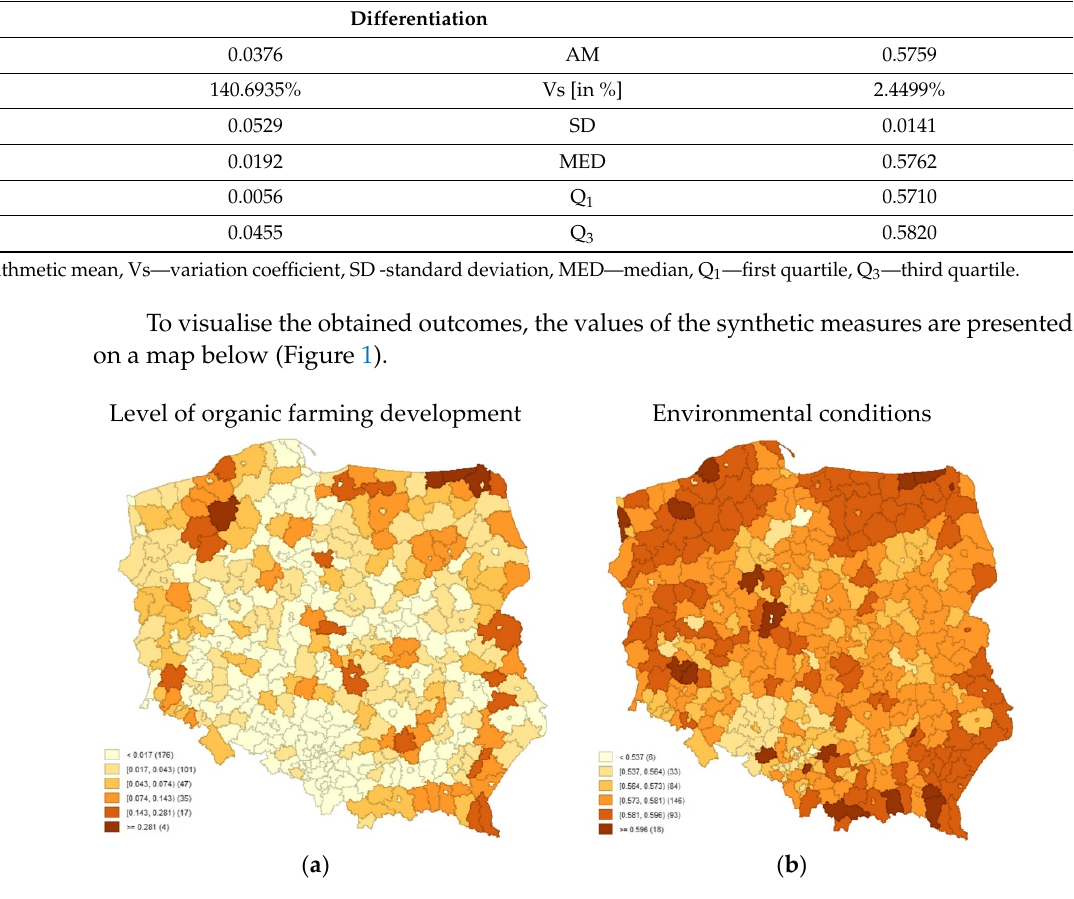
Figure 1. The differentiation of the organic farming development level ( a ) and environmental conditions ( b ).